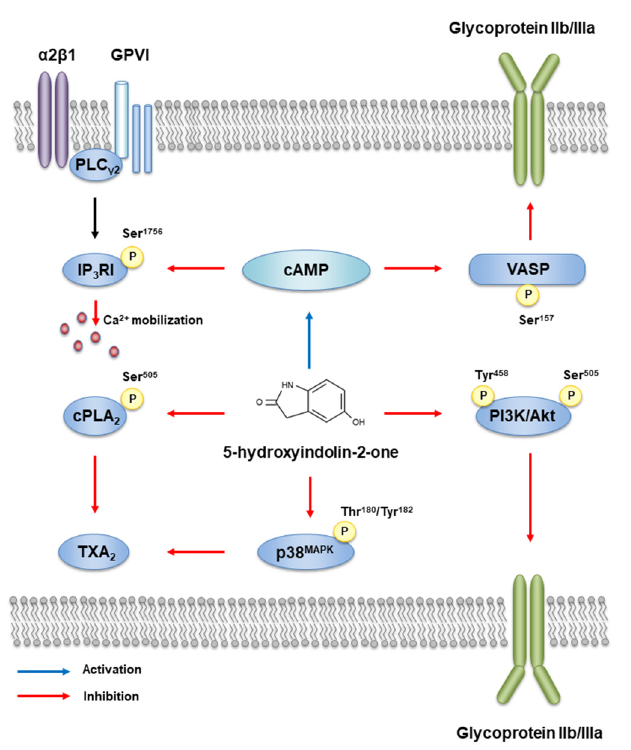
Figure 6. A schematic summary of inhibitory effects of 5-HI on platelet intracellular signaling pathway.